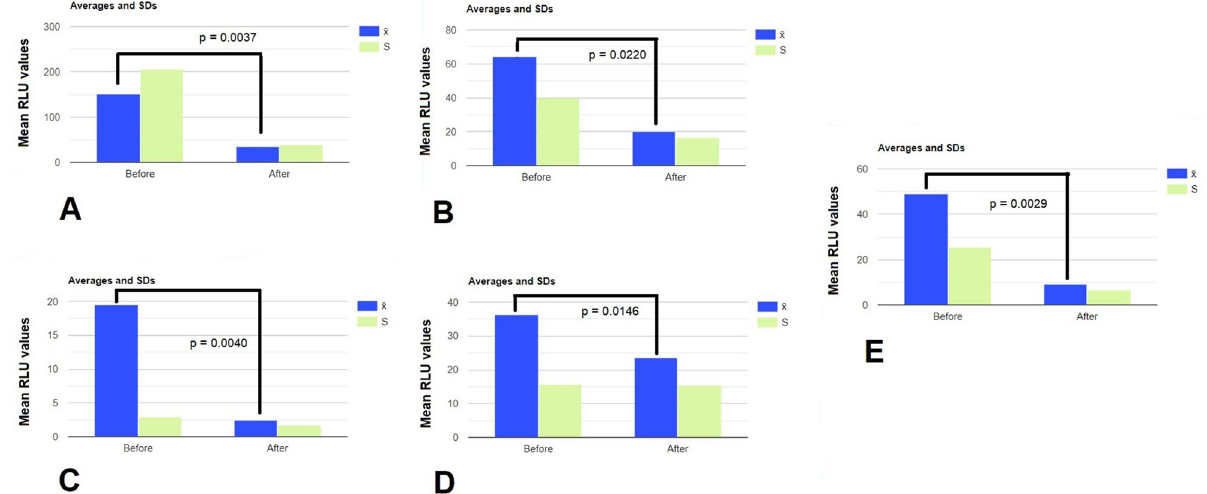
Figure 3. Means (blue) ± standard deviation (SD) (light green) of the RLU values (control vs TiO 2 –Ag–NP treated areas for each investigated indoor place: ( A ): school; ( B ): farm showroom; ( C ): farm housing cabs; ( D ): laundry; ( E ): shop. Statistics with Kolmogorov–Smirnov (KS) test and two tailed paired t-test at p <